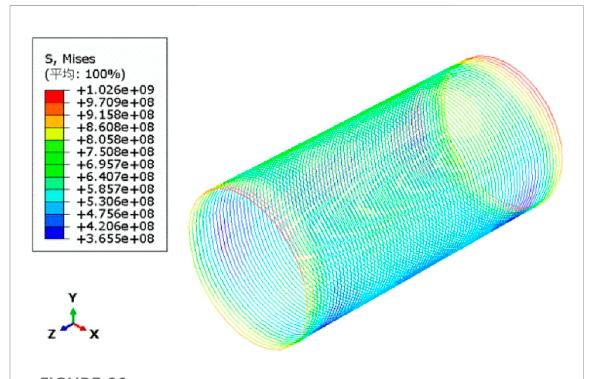
FIGURE 20 Nephogram of the prestressed strands at design